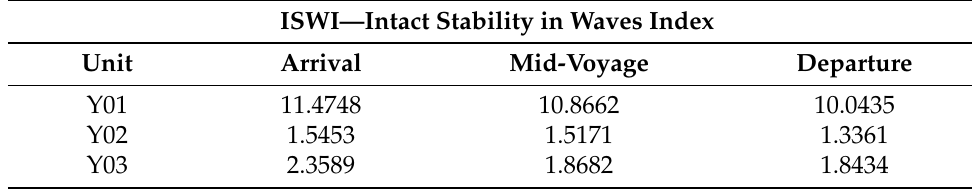
Table 9. Summary of the evaluation of the ISWI for all investigated loading conditions.